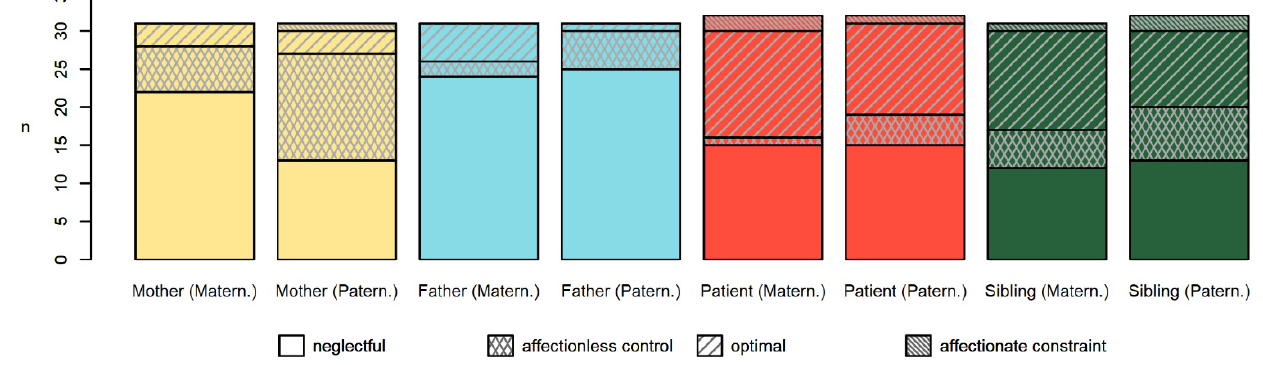
Figure 2. Parental Bonding Inventory in family members. The stacked bar plot represents the proportions of perceived parenting styles coded from the PBI scores. For each participants’ group, the categories distributions are presented both for maternal and paternal relationship (in parentheses).